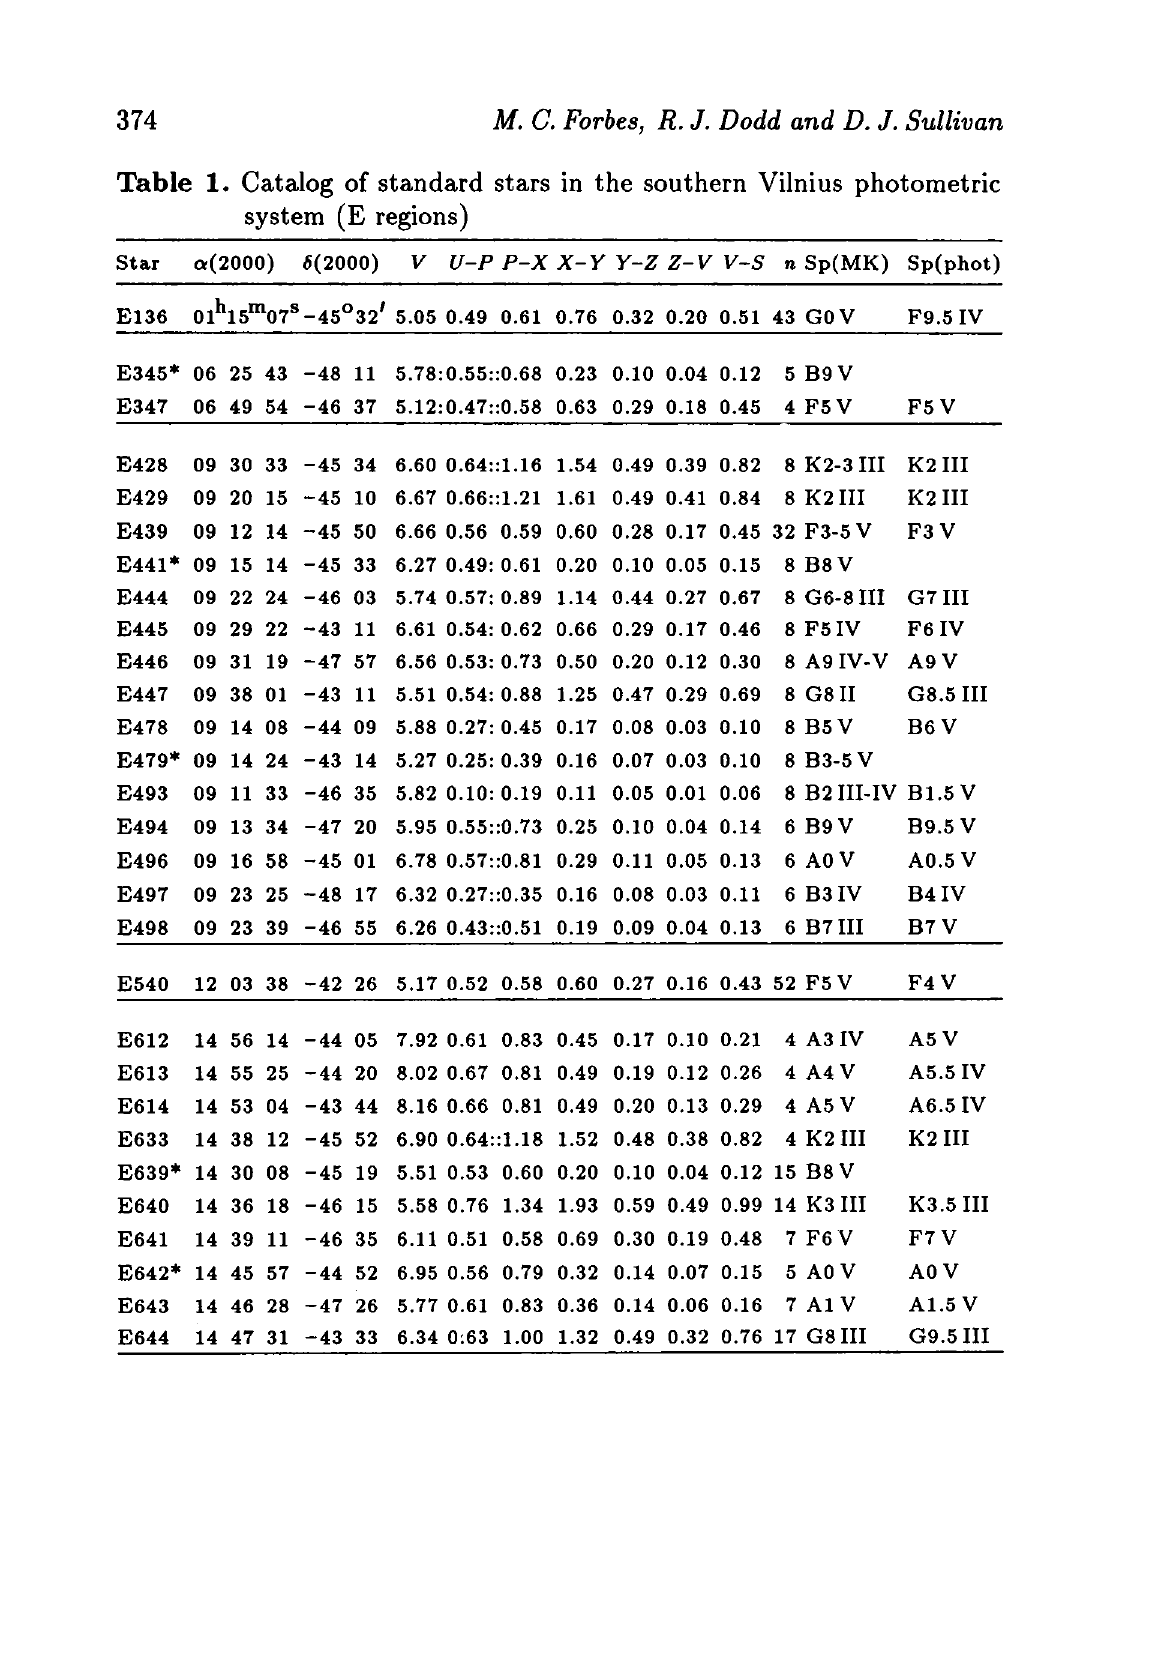
Table 1. Catalog of standard stars in the southern Vilnius